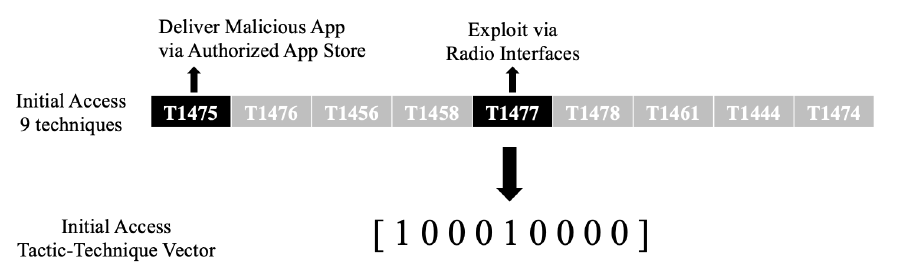
Figure 3. The ATT&CK matrix helps create a common language for the adversary group’s attack behavior. Our study vectorized the tactics and techniques from the APT